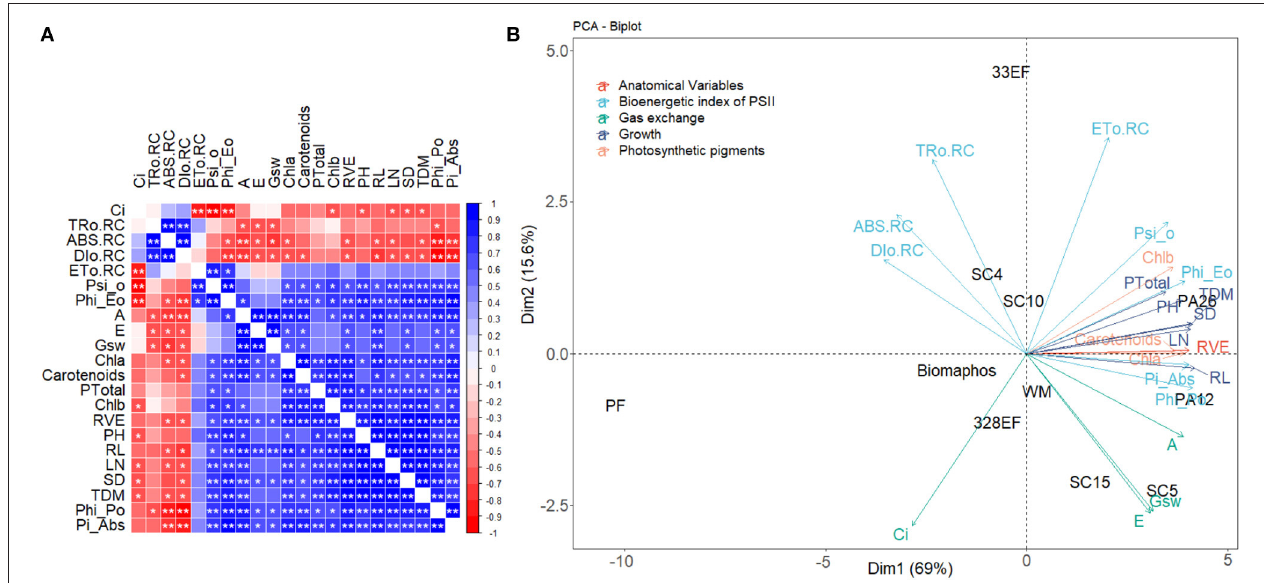
FIGURE 9 | Analysis of the main components of growth variables, photosynthetic pigments, gas exchange, chlorophyll- a fluorescence parameters, and anatomical development of root vessel elements (A) and correlations between the means observed for these variables (B) in soybean plants ( Glycine max ) grown in nutrient solution providing calcium phosphate (CaHPO 4 ) as a phosphate source and inoculated with four bacterial strains and four fungal strains. SC5, B. cereus ; SC10, B. thuringiensis ; PA1, P. alvei ; PA26, L. fusiformis ; SC15, P. sheari ; SC4, E. keratinophilum ; 33EF, H. insecticola ; 328EF, Codinaeopsis sp.; Biomaphos ® , B. megaterium and B. subtilis ; WM, without microorganisms; PF,